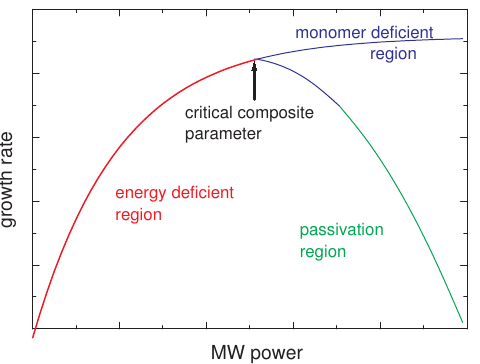
Figure 4. Schematic diagram of the growth rate as function of power input of a mother molecule M 2 which is going to be dissociated by a bimolecular plasma reaction after Yasuda and Hirotsu